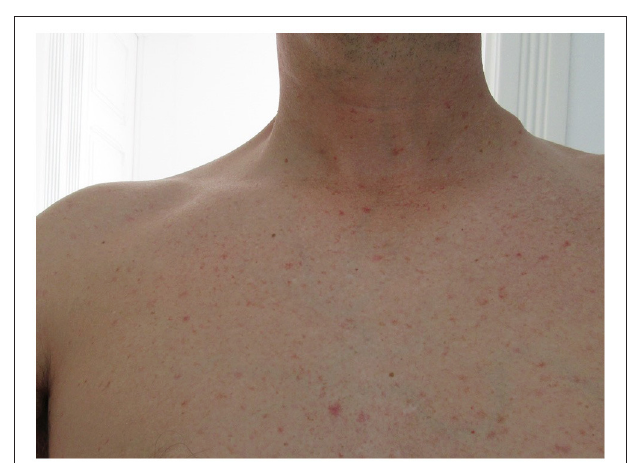
FIGURE 2 | Left cervical adenopathy taken on the 15th